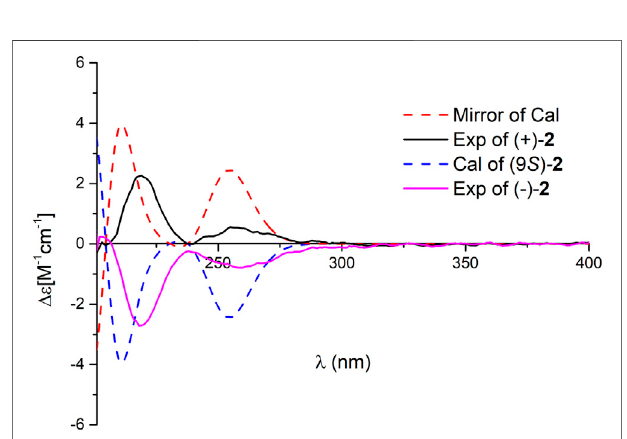
FIGURE 4 | Comparison of the calculated ECD spectrum of 2 at the APFD/6 – 311+ g (2 d,p) level with the experimental one in MeOH. σ (cid:1) 0.25 eV; shift (cid:1) − 25 nm.